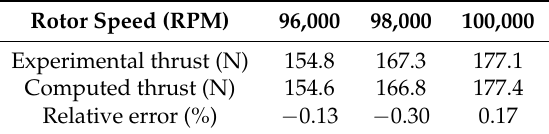
Table 2. Comparison of the experimental thrust and the modeled thrust.